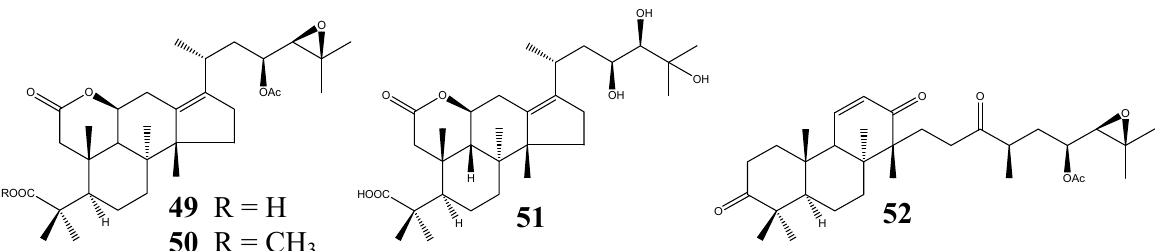
Figure 5. Structures of the seco -protostanes.